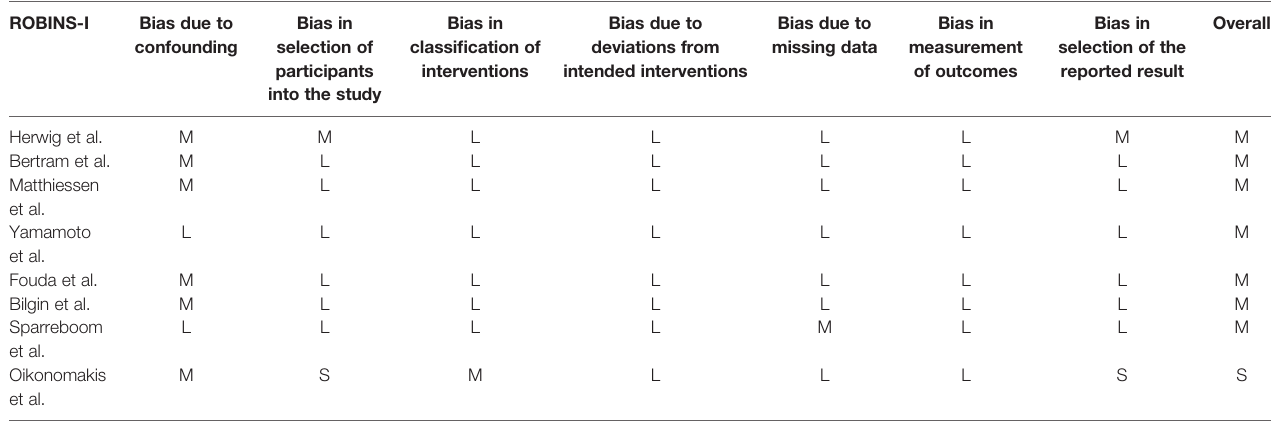
TABLE 1 | Quality assessment of non-randomized using risk of bias in nonrandomized studies of interventions.